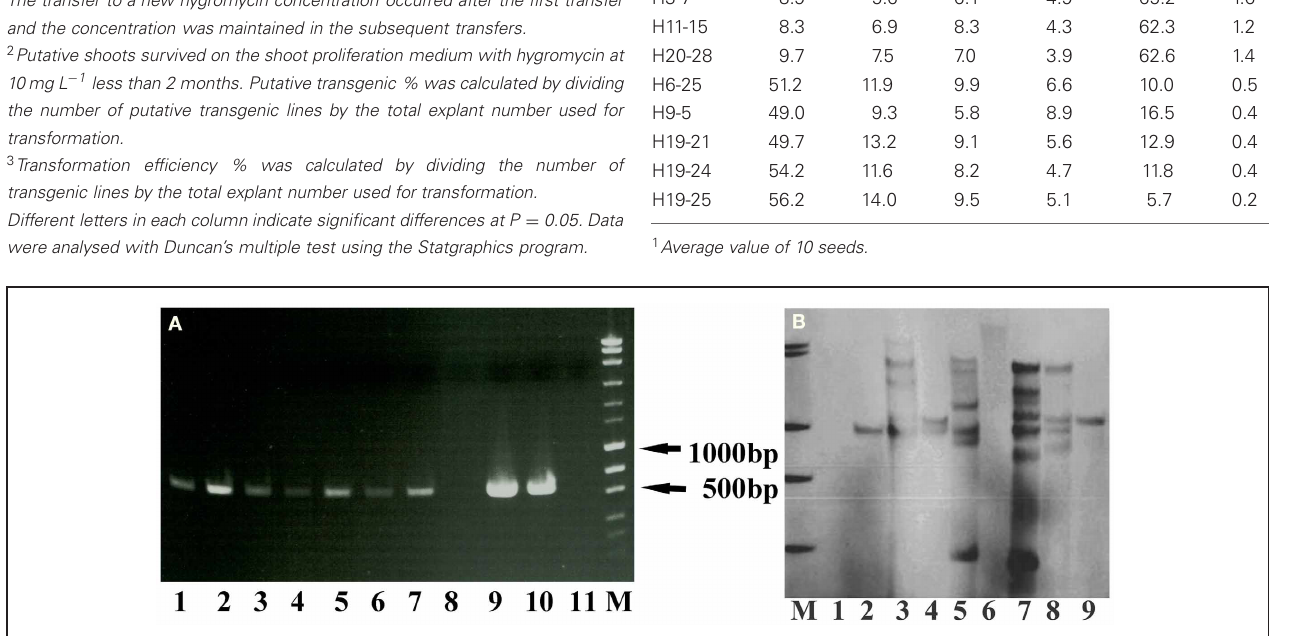
FIGURE 3 | PCR and Southern blot results of the putative transgenic lines of crambe. (A) The PCR product size of the hpt gene is 579bp. Lane 1–10, putative transgenic lines. Lane 11, wild type. M, molecular markers (MassRuler “Express DNA ladder Mix”